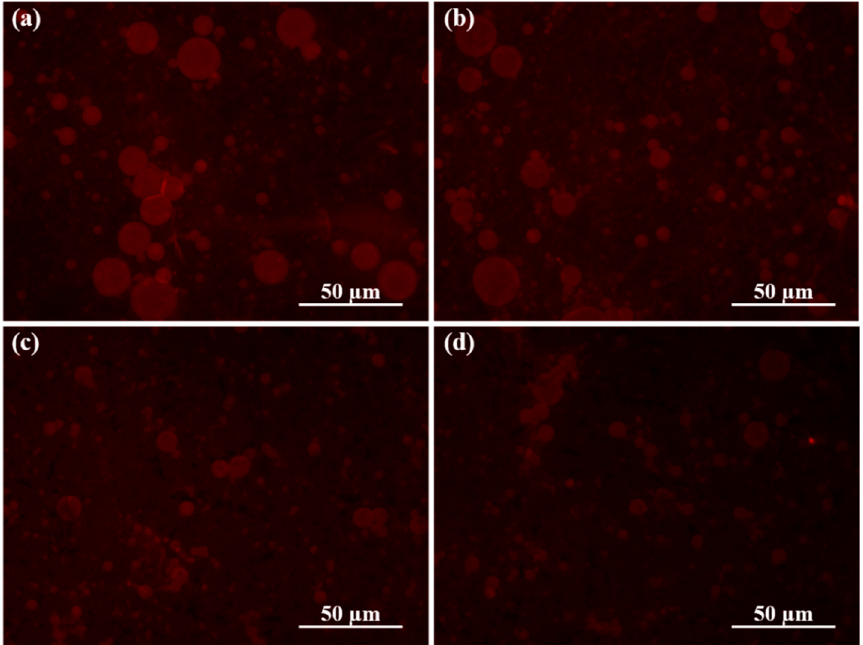
Figure 8. Fluorescent images of the dyed microcapsules emulsions stabilized by ( a ) HAD, ( b ) OAD, ( c ) DAD, and ( d ) LAD under dark field. Table 3. SA, HAD, OAD, DAD, and LAD microcapsules fitting results for the ibuprofen release data.